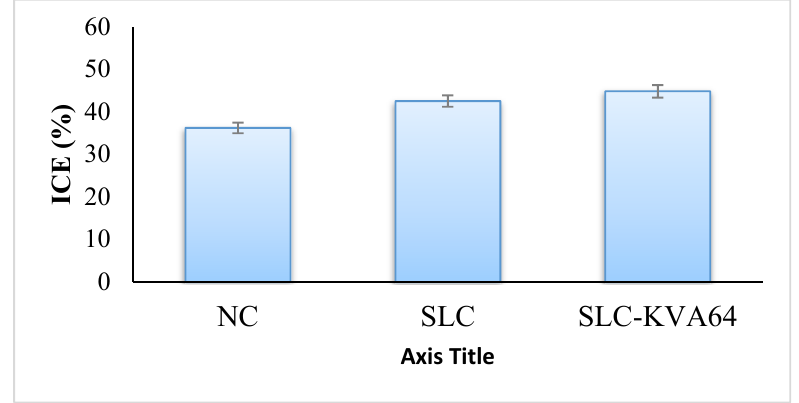
Figure 8. Effect of pure SLC and SLC-KV64 on ICE.